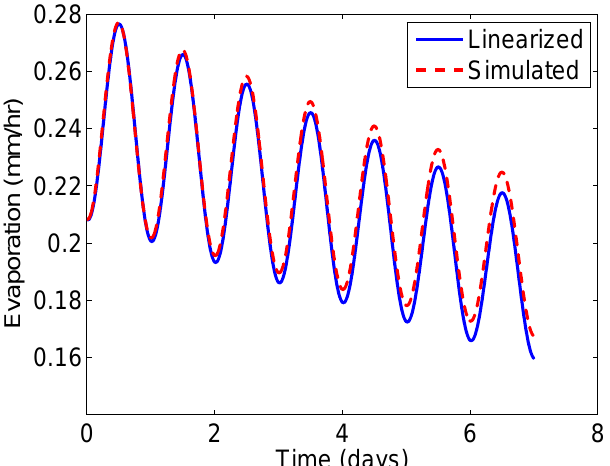
Figure A1. The evaporation patterns obtained from solving the linearized system and from simulations in